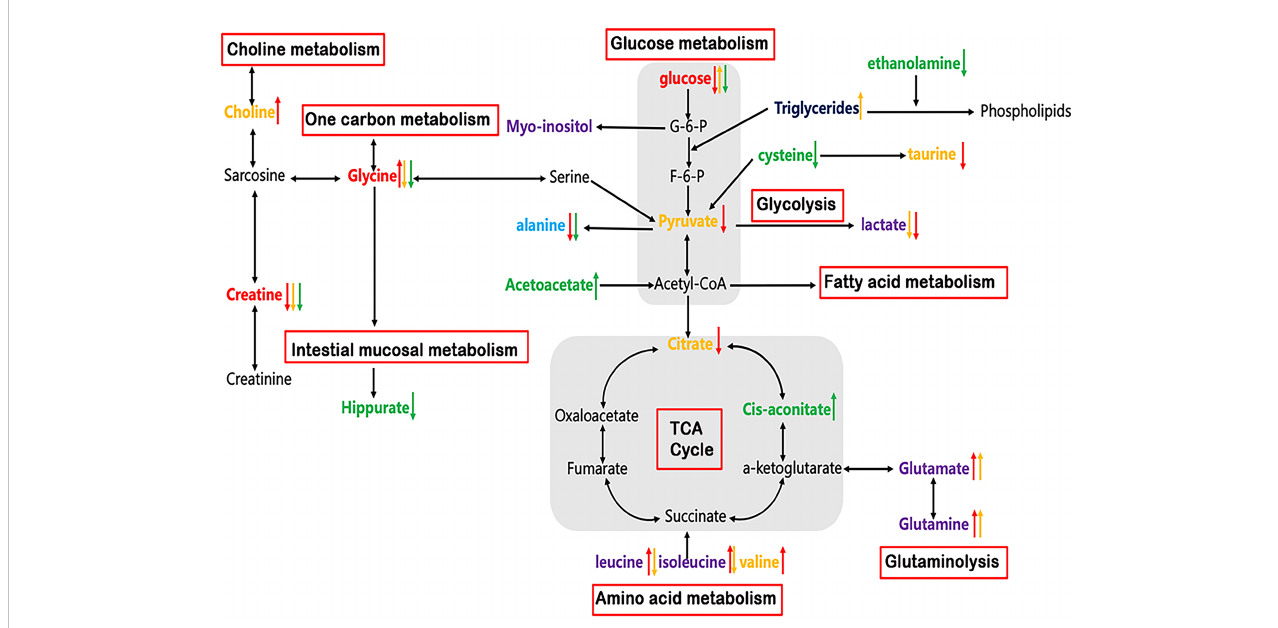
FIGURE 6 Altered metabolic pathways for the most relevant distinguishing metabolites (Red: common changed metabolites in tissue, serum and urine; Purple: changed metabolites in both tissue and serum; Light blue: changed metabolites in both tissue and urine; Yellow: tissue-speci fi c metabolites; Navy: serum-speci fi c metabolites; Green: urine-speci fi c metabolites. Red arrow: increased or decreased with respect to control in tissue; Yellow arrow: increased or decreased with respect to control in serum; Green arrow: increased or decreased with respect to control in